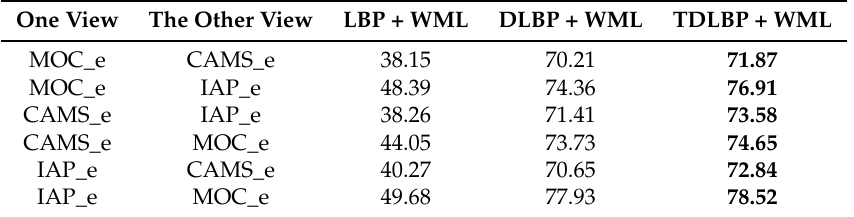
Table 5. Multi-view cloud recognition accuracies (%) comparing the proposed method with LBP + WML and DLBP + WML.